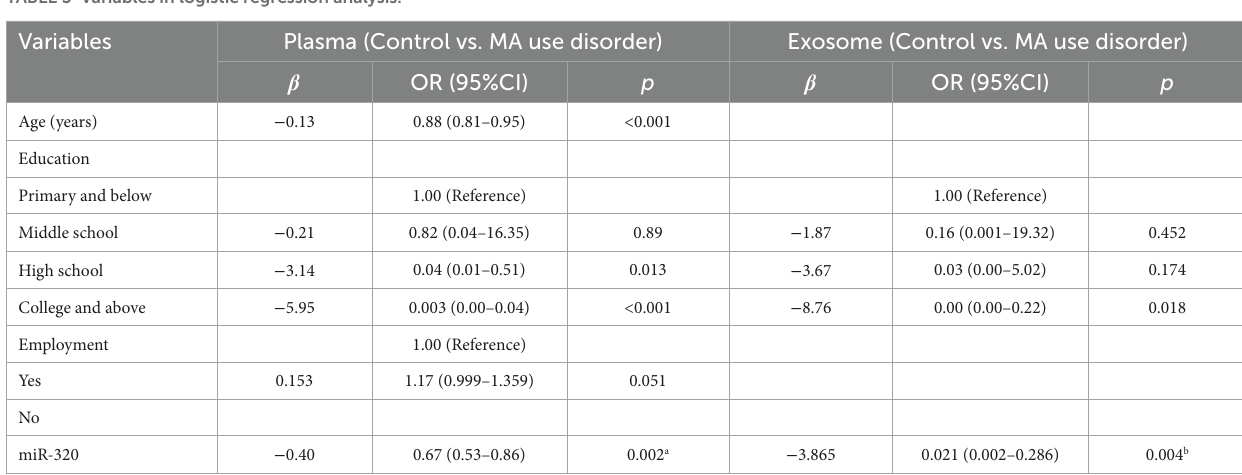
TABLE 3 Variables in logistic regression